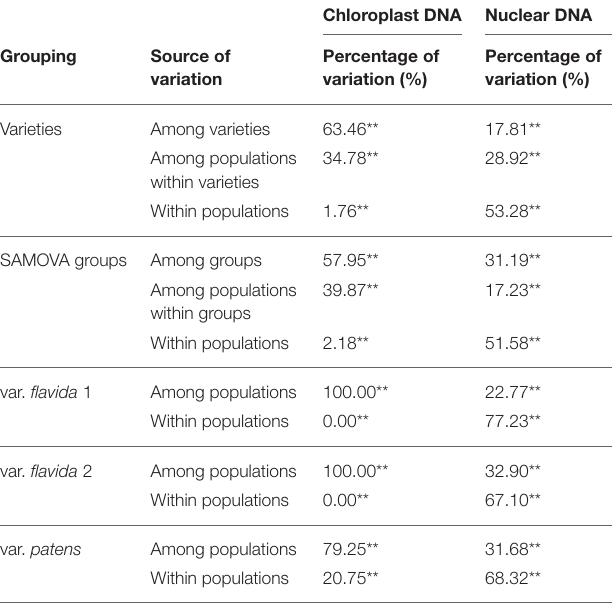
TABLE 4 | Analyses of molecular variance (AMOVA) based on cpDNA and nuclear DNA from C. flavida . Chloroplast DNA Nuclear